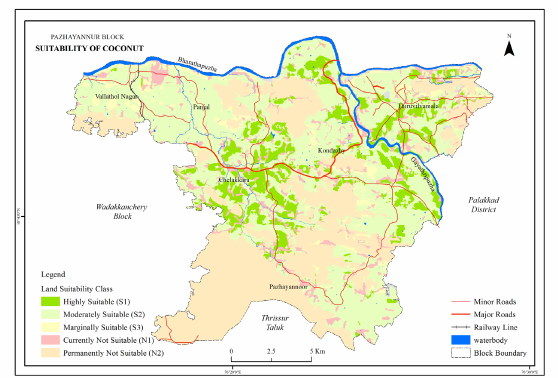
Figure 3. Land Suitability for Coconut